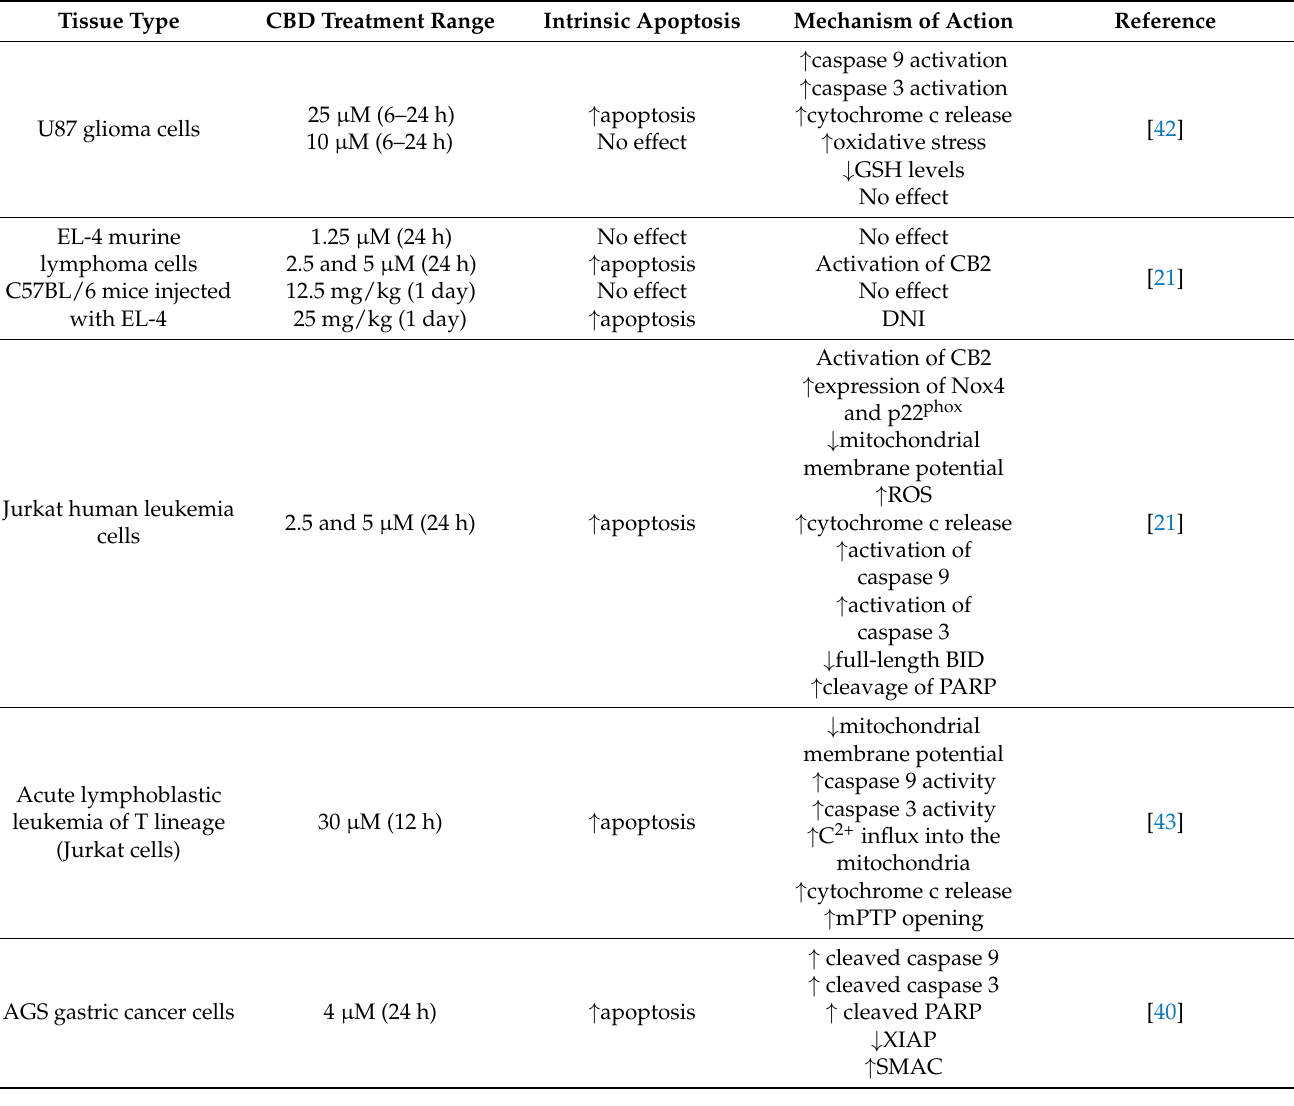
Table 3. Effects of CBD on intrinsic